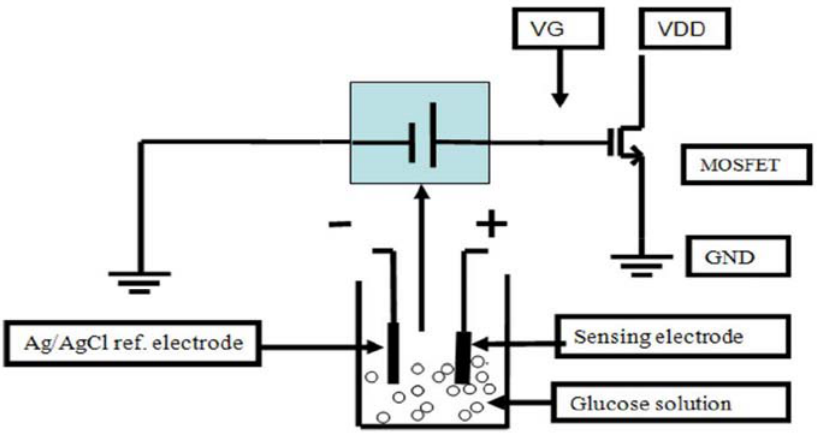
Figure 1. Schematic illustration of the configuration of the MOSFET-based potentiometric glucose detection using an extended-gate functionalized-ZnO nanowire as a working electrode and the Ag/AgCl reference electrode (reproduced with permission from